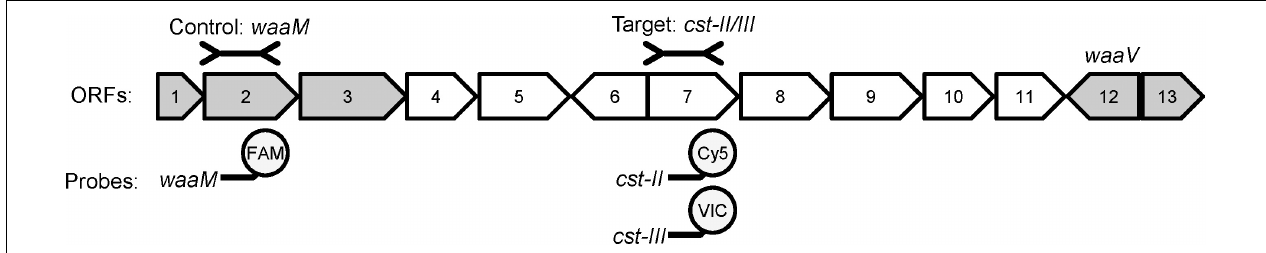
FIGURE 1 | The LOS biosynthetic locus contains variable and conserved genes required for LOS gangliosdide mimicry. An example of the gene organization of LOS type A ( cst-II positive) is shown [adapted from Parker et al. (2005)]. ORFs conserved amongst all LOS types are shown in gray, while variable ORFs are shown in white. The control and target regions used in the qPCR are shown above the diagram, and the fluorophores used for each gene are shown below. ORF2 ( waaM ) encodes an acyltransferase involved in Lipid A biosynthesis and is highly conserved. ORF7 encodes cst-II in LOS types A and B, and cst-III in LOS type C. ORF12 ( waaV ) is a highly conserved putative glycosyltransferase. The gene content of the variable region between waaM and waaV determines the LOS